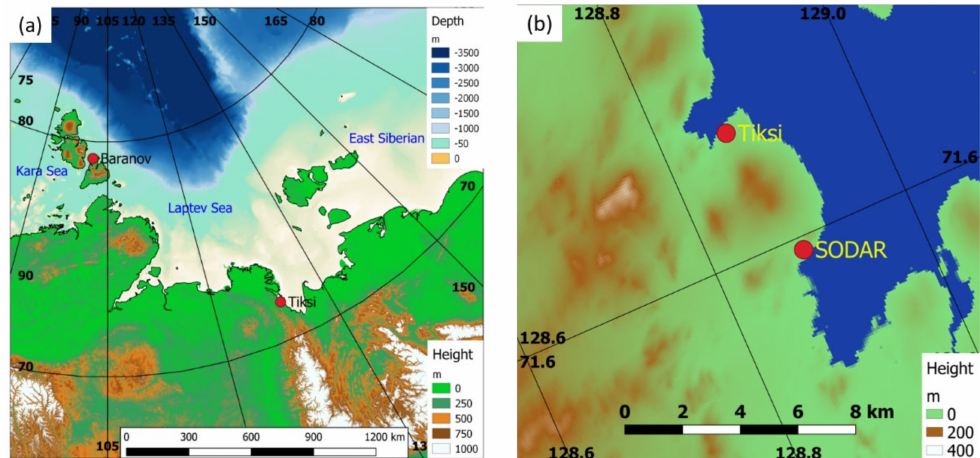
Figure 1. ( a ) Map of the Laptev Sea with topography and bathymetry. The Russian observatories near Tiksi and at the Cape Baranov are marked by red dots. ( b ) Map of the Tiksi area with topography. The town of Tiksi and the location of the Sound Detection and Ranging (SODAR) at the Tiksi observatory are marked.